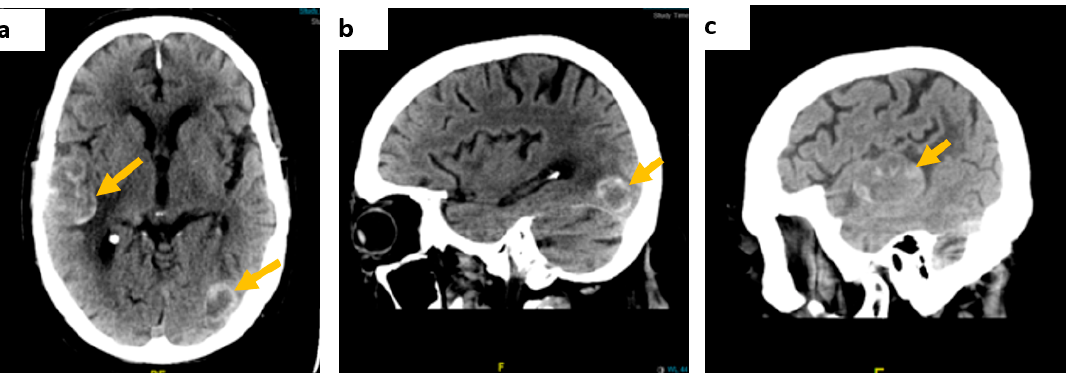
Figure 1. Contrast-enhanced brain CT scan images. ( a ) On axial view, a right temporoparietal lobe lesion measuring approximately 54 × 33 mm and a smaller left temporal lesion, ( b ) on sagittal view, a left occipital lobe lesion, measuring approximately 23 × 18 mm, and ( c ) the right temporal lesion on the sagittal axis.